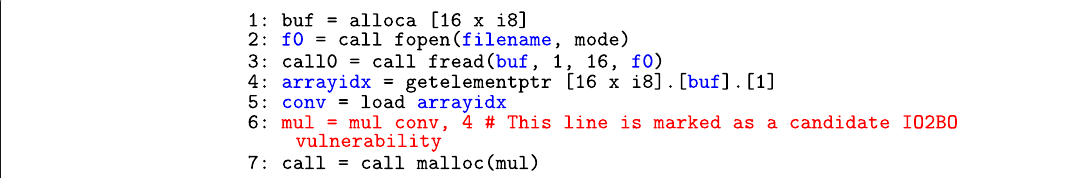
Fig. 8 Sample code for illustrating potential IO2BO vulnerabilities identification